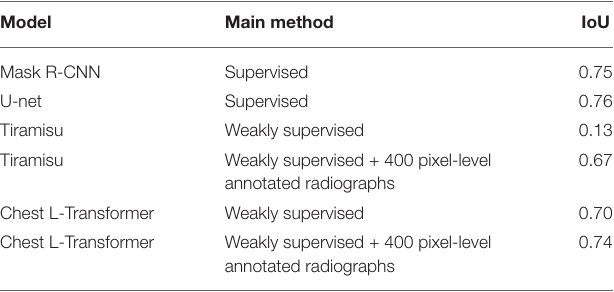
TABLE 2 | Comparison of Chest L-Transformer with the state-of-the-art segmentation models (segmentation). Model